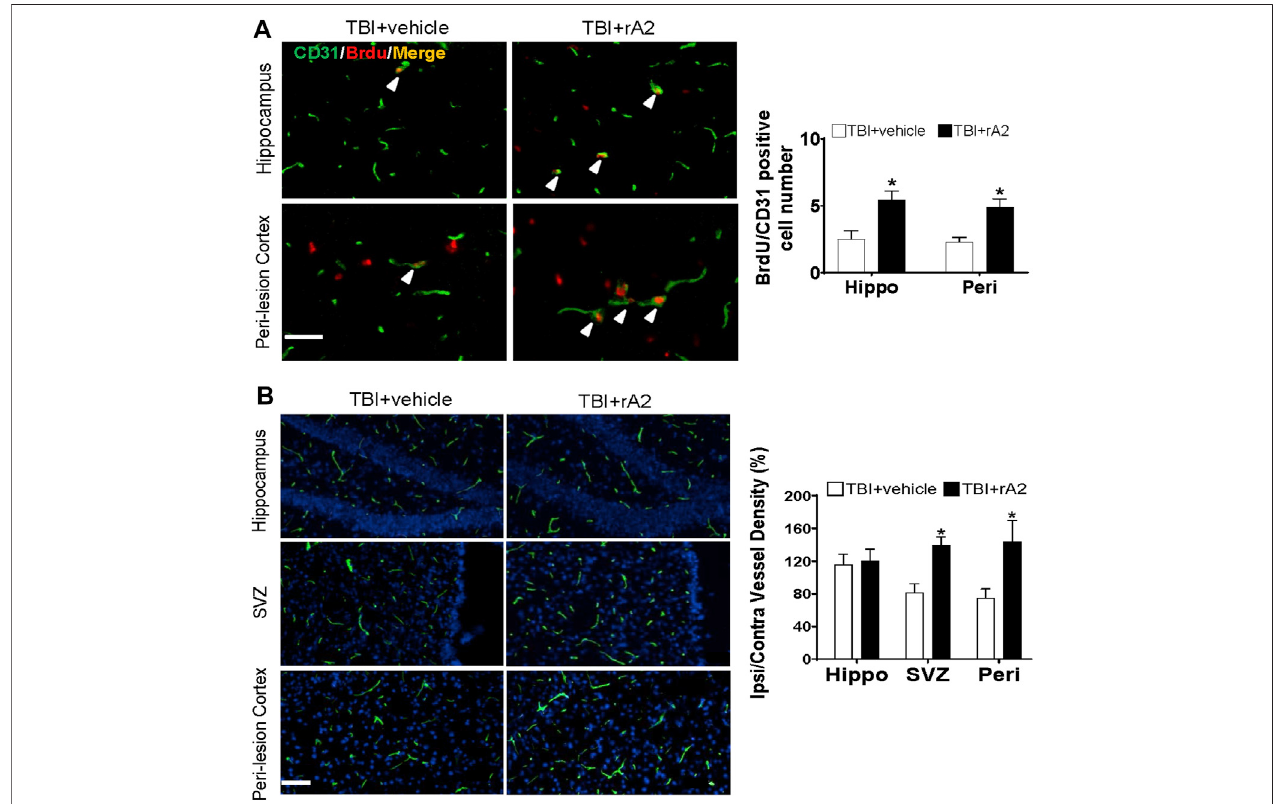
FIGURE4| rA2administrationenhancescerebralangiogenesisandfunctionvesseldensityafterTBIinmice.Cerebralangiogenesiswasdeterminedat14 days after TBI by bromodeoxyuridine (BrdU) and CD31 double immunostaining method, and functional vessel density was examined at 28 days by lectin perfused brain vessels analysis. (A) . Representative images and quanti fi cation of CD31 + /BrdU + cells (indicated by white arrows, cell number per fi led) at hippocampus (Hippo) and peri-lesion cortex (Peri) areas of TBI mouse brains. (B) . Representative images of lectin and quanti fi cation of ipsilateral/contralateral vessel density (%) in the hippocampus (Hippo), SVZ, and peri-lesion cortex (Peri) areas of TBI mouse brains. Scale bar (cid:1) 50 μ m. Data are expressed as mean ± SEM, n (cid:1) 6 mice per group. * p < 0.05 vs. TBI+vehicle (1 mg/kg BSA).